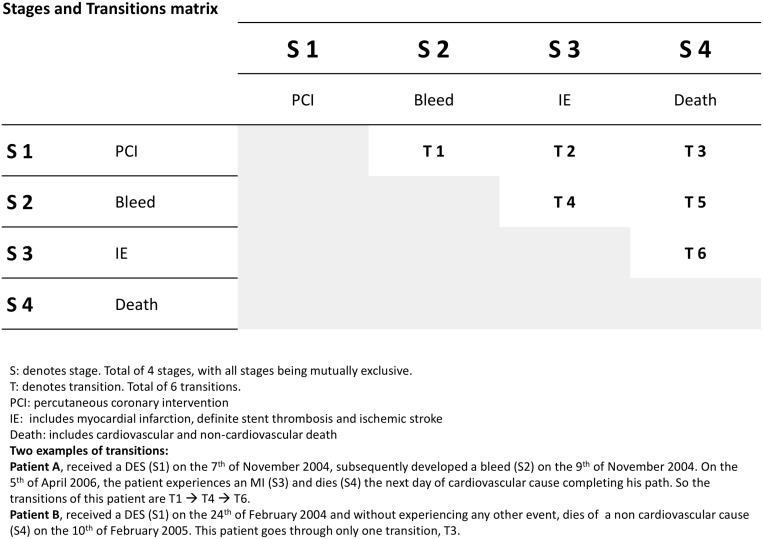
illustrates the four stages of disease included into the multi-state analysis and the six stage-to-stage transitions a patient may experience from the time of PCI to death or end of follow-up.